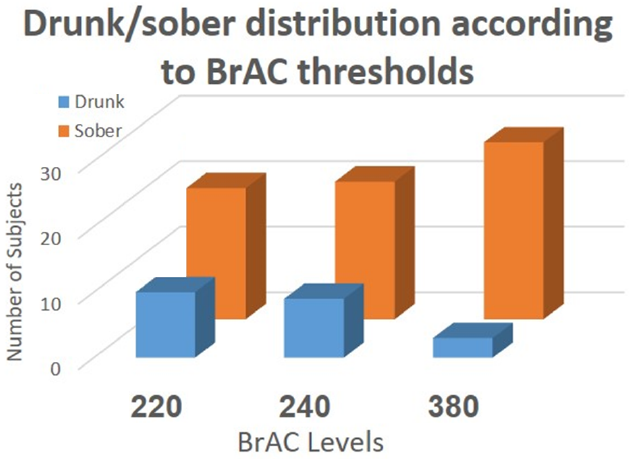
Figure 3. A breakdown of the subjects’ state (sober/drunk) at various BrAC